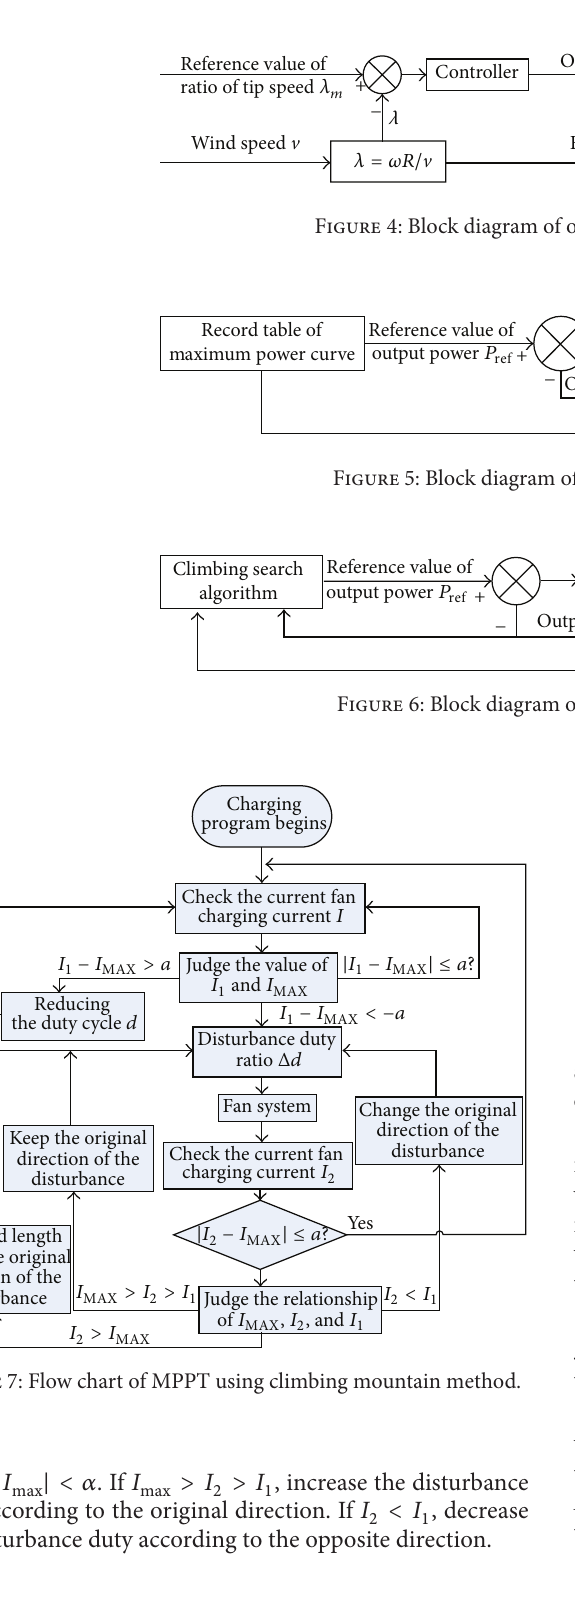
If |𝐼 2 − 𝐼 max | < 𝛼 . If 𝐼 max > 𝐼 2 > 𝐼 1 , increase the disturbance duty according to the original direction. If 𝐼 2 < 𝐼 1 , decrease the disturbance duty according to the opposite direction.